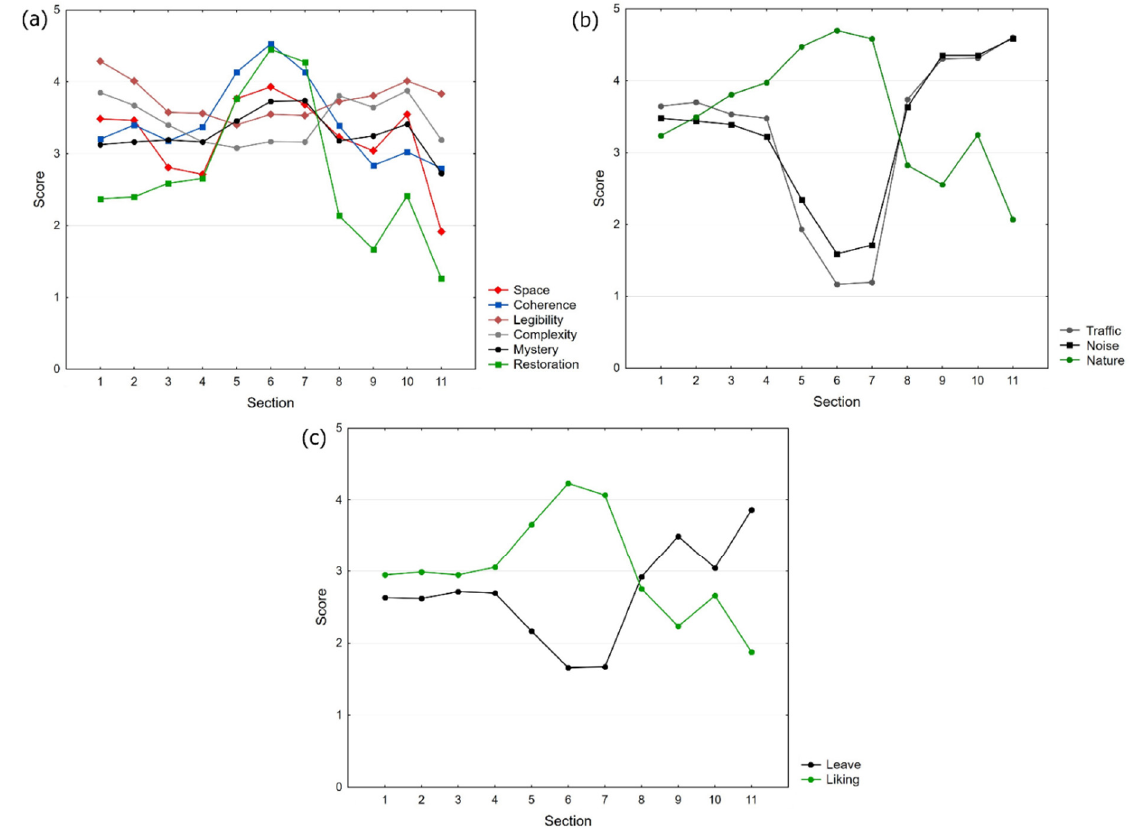
Figure 3. Average scores for spatio-cognitive dimensions ( a ), properties of the environment ( b ) and intention to leave the environment and liking ( c ).